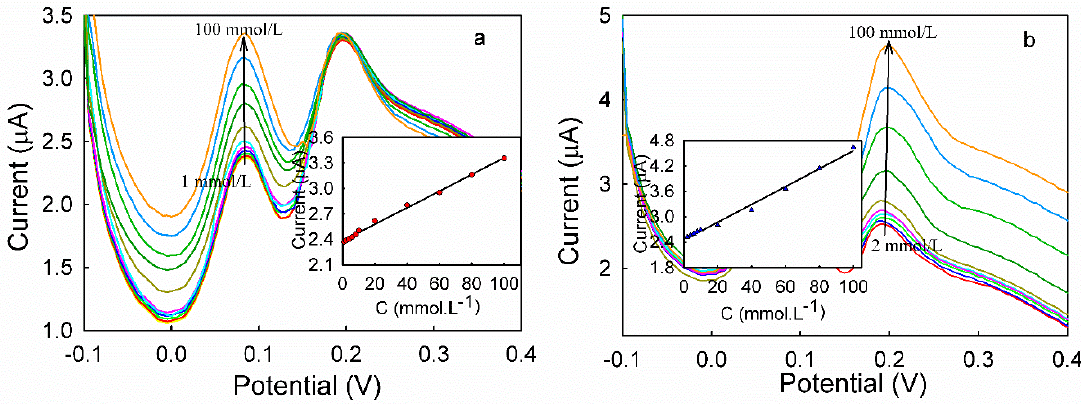
Figure 11. ( a ) DPV results of the PGDIL–TiO 2 / Au in the presence of 0.1 mmol / L HQ with CC at di ff erent concentrations (the inset is the calibration curve of the peak current and target concentration). ( b ) DPV results of the PGDIL–TiO 2 / Au in the presence of 0.05 mmol / L CC with HQ at di ff erent concentrations (the inset is the calibration curve of the peak current and target concentration). The scan rate is 0.1 V / s.